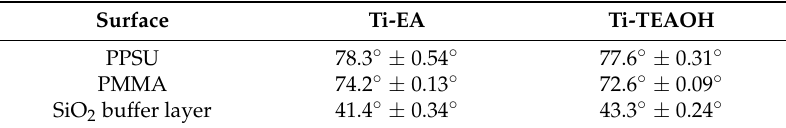
Figure 2. In-situ dispersive Raman spectrum of the pre-condensation process during silica precursor synthesis. Table 2. Measured contact angles of Ti-EA and Ti-TEAOH coating suspensions (microwaved at 140 ◦ C for 30 min) on uncoated and SiO 2 -coated polyphenylsulphone (PPSU) and PMMA substrates.